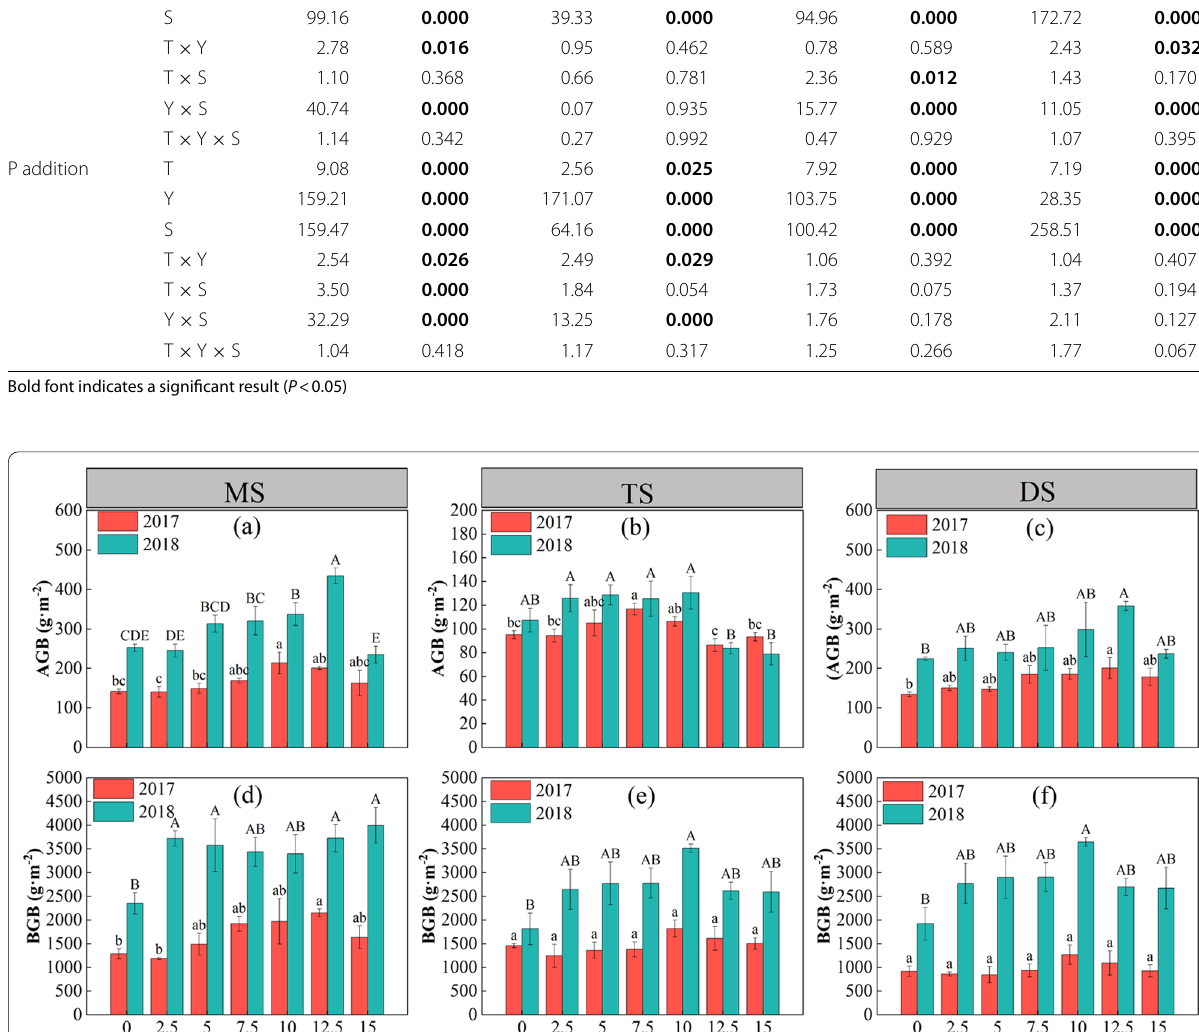
Fig. 4 Effect of experimental P addition on above- (( a ) MS, ( b ) TS, ( c ) DS) and below-ground biomass (( d ) MS, ( e ) TS, ( f ) DS) of three temperate steppes from 2017 to